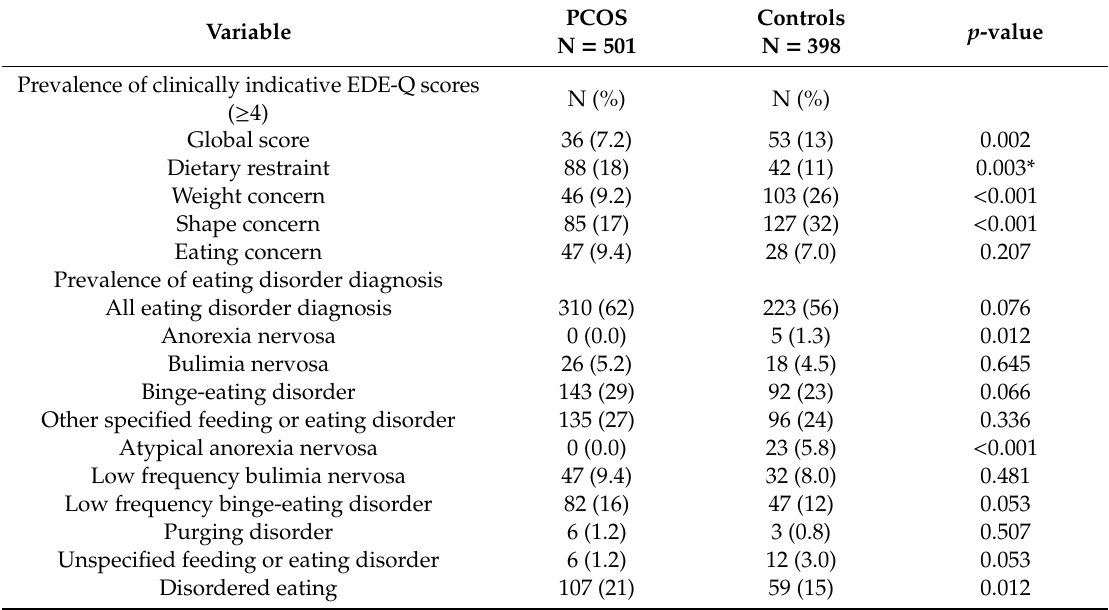
Table 2. EDE-Q survey results for women with and without PCOS.